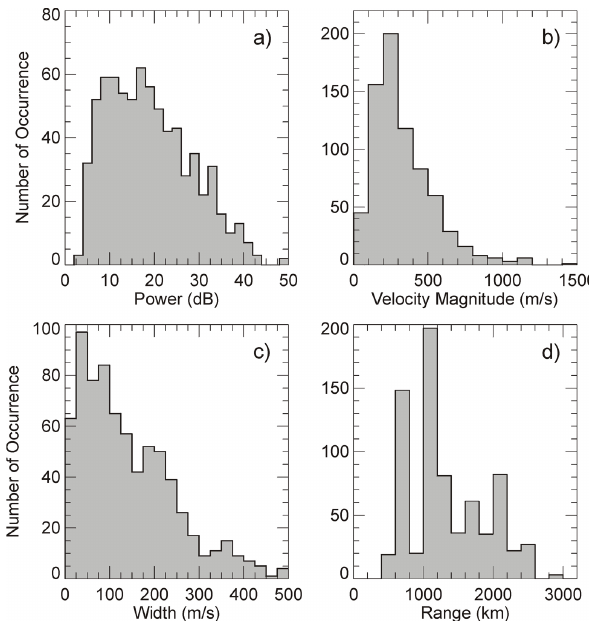
Fig. 4. The histogram distributions of the SuperDARN radar (a) echo power, (b) velocity magnitude, (c) spectral width and (d) slant range for all events selected for a comparison with DMSP.